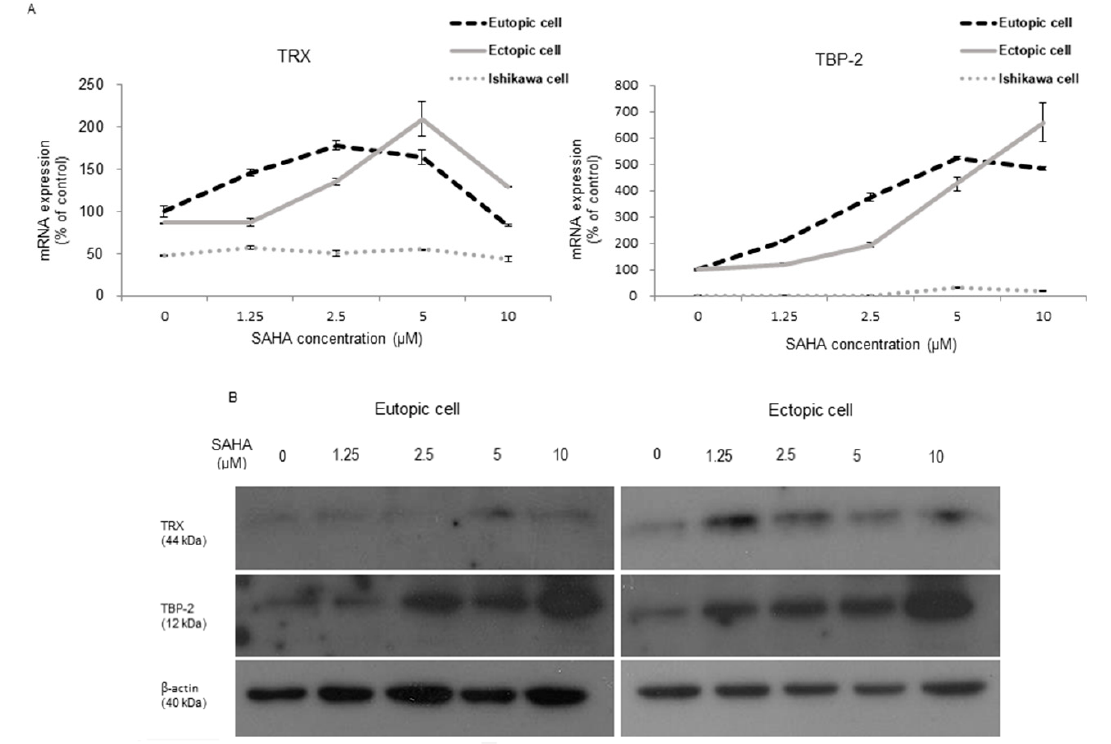
Figure 1. TRX and TBP-2 expression in endometrial cells, before and after treating with SAHA. ( A ) Relative mRNA levels of TRX, TBP-2 was presented according to the treatment doses. There was no difference in the mRNA level in Ishikawa cells, but there was a significant increase in HESCs up to 5 µ M of SAHA treatment. ( B ) Representative immunoblots revealed increased TRX and TBP-2 in eutopic and ectopic HESCs, by Western blot; β -actin was used as an internal control.